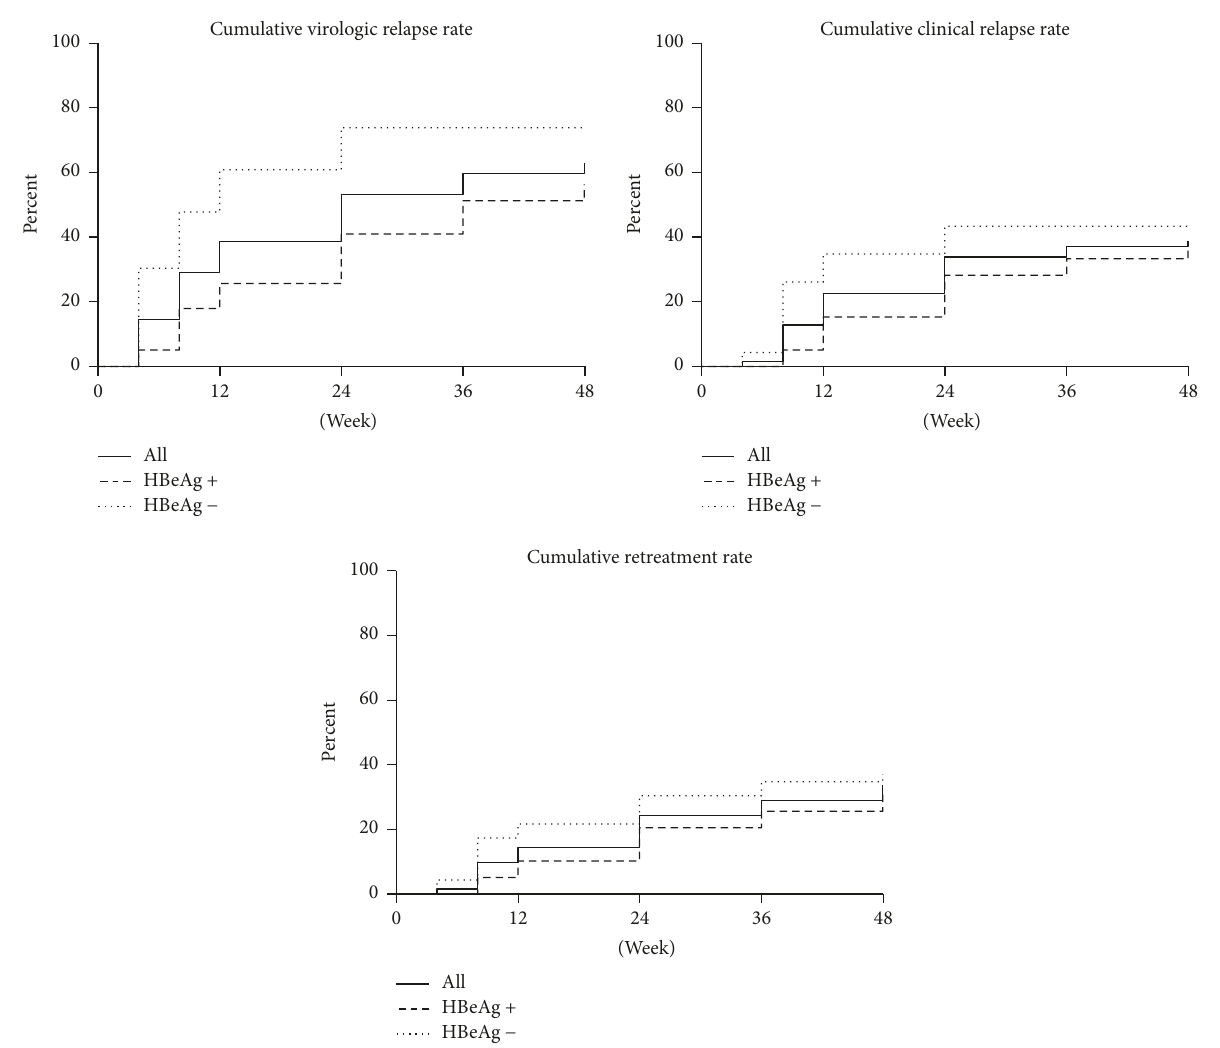
Figure 3: Forty-eight-week cumulative rates of virologic relapse, clinical relapse, and retreatment.